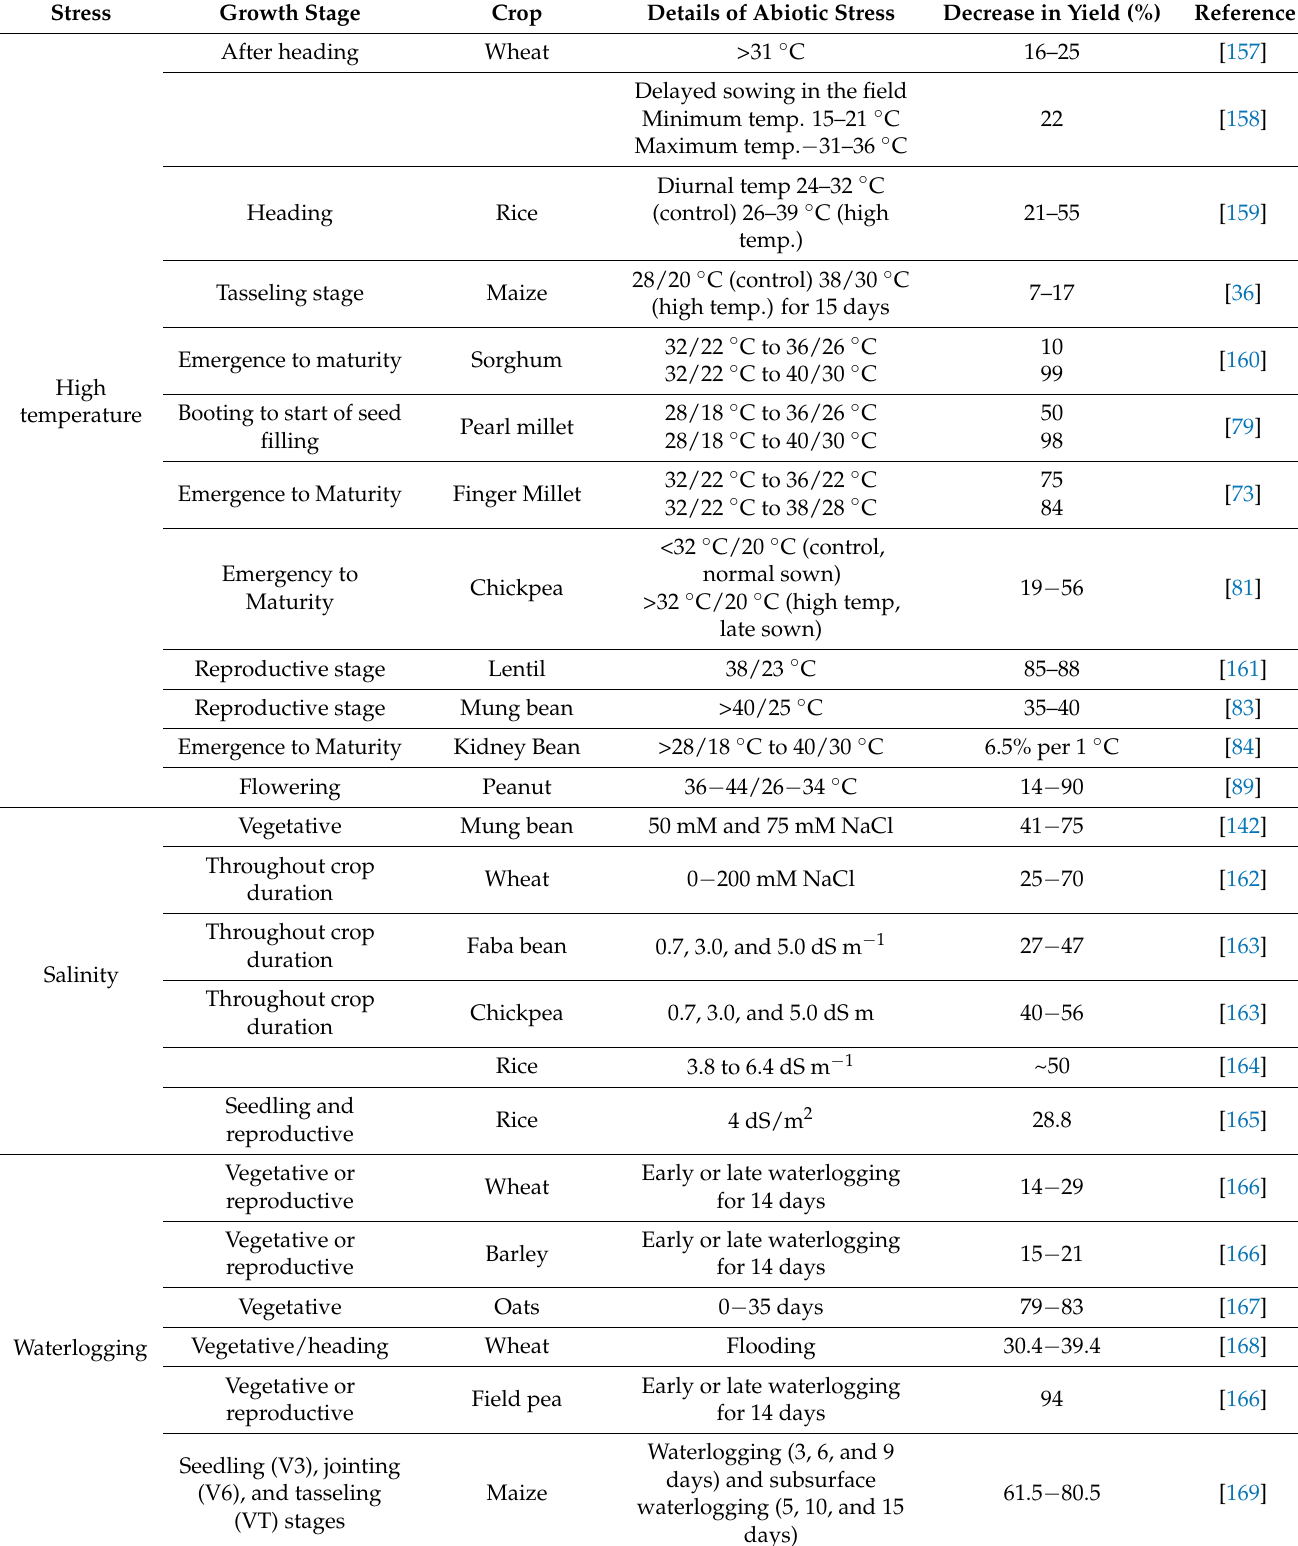
Table 5. Impact of abiotic stresses on grain yield of cereals and